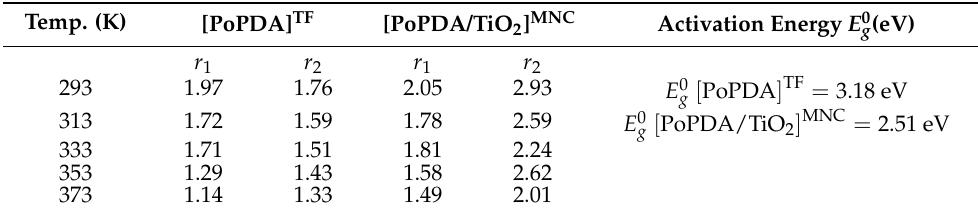
Table 5. The values of the nonlinear coefficient parameters ( r 1 and r 2 ) for Au/[ PoPDA/TiO 2 ] MNC /n- Si/Al heterojunction diode. Temp. (K) [PoPDA] TF [PoPDA/TiO 2 ] MNC Activation Energy E 0